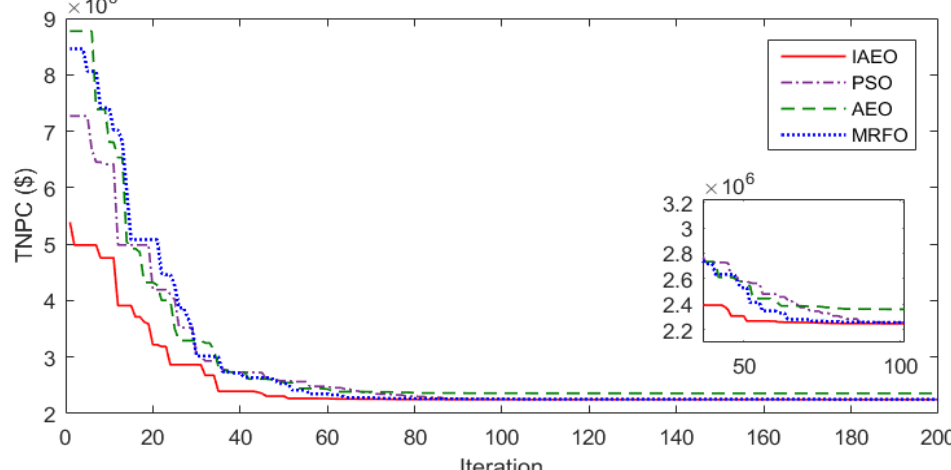
Figure 12. Convergence process of different algorithms in the sizing of the HPV/FC energy system considering an ENSP max of 5%. Table 5. Results related to scaling the HPV/FC energy system considering ENSP max = 5%.